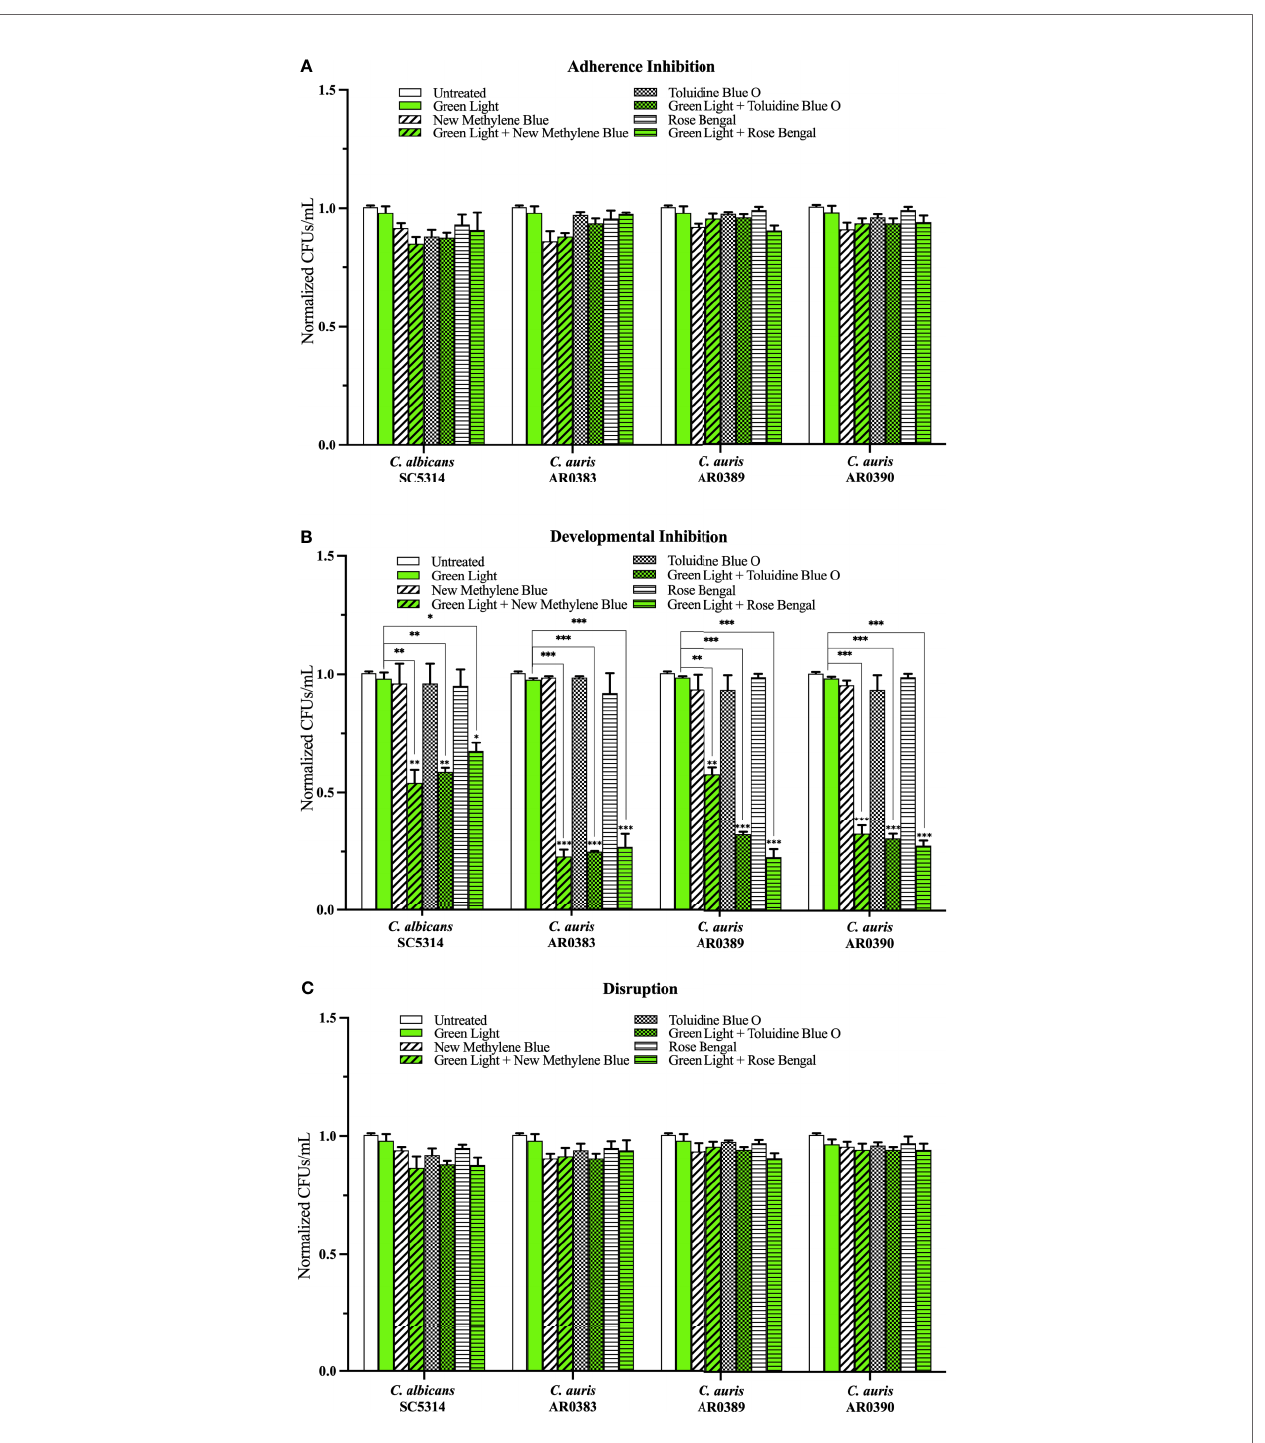
FIGURE 4 | Green visible light in combination with photosensitizing compounds is effective against C . auris bio fi lms. C albicans (SC5314) and C . auris (AR0383, AR0389, and AR0390) bio fi lms were exposed to green visible light with and without the photosensitizing compound indicated in the (A) adherence inhibition, (B) developmental inhibition, and (C) disruption bio fi lm assays. Untreated control (Untreated), green light alone (Green Light), photosensitizing compound alone (New Methylene Blue, Toluidine Blue O, and Rose Bengal), and green light in combination with the photosensitizing compound (Green Light + New Methylene Blue, Green Light + Toluidine Blue O, and Green Light + Rose Bengal) are shown. CFUs/mL were counted to determine viable cell counts at the end of each of the bio fi lm assays. Standard deviations are shown for each sample (n = 3). The average CFUs/mL of the untreated control samples for each assay were normalized to 1. Signi fi cance comparisons are relative to the untreated control unless otherwise noted with signi fi cance bars and were determined using student ’ s unpaired two-tailed t-tests assuming unequal variance for p ≤ 0.05 (*), and p ≤ 0.01 (**) and p ≤ 0.001